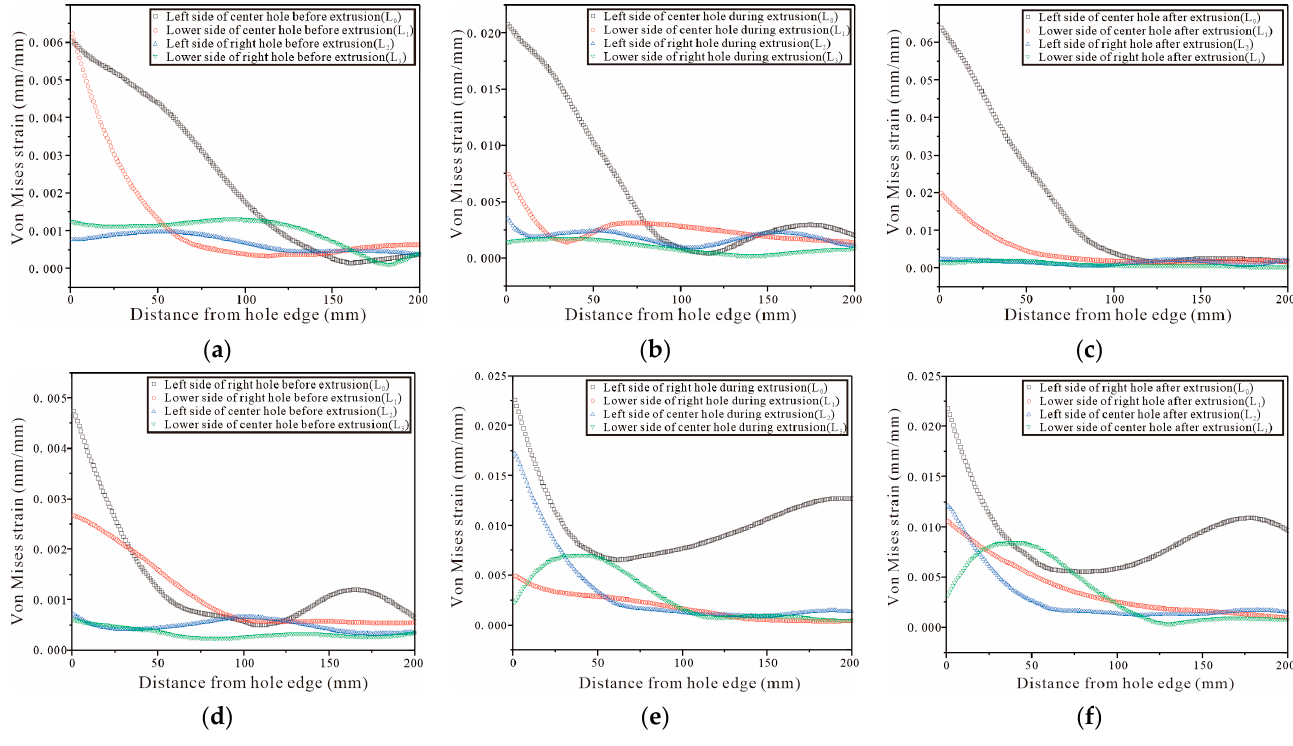
Figure 27. Von Mises strain for the left and lower sides of triple-pitch three-hole specimens (first, the center hole is cold expanded, then the left hole, and finally the right hole): ( a – c ) strain distributions before, during, and after SSCE of the middle hole; ( d – f ) strain distributions before, during, and after SSCE of the right hole.